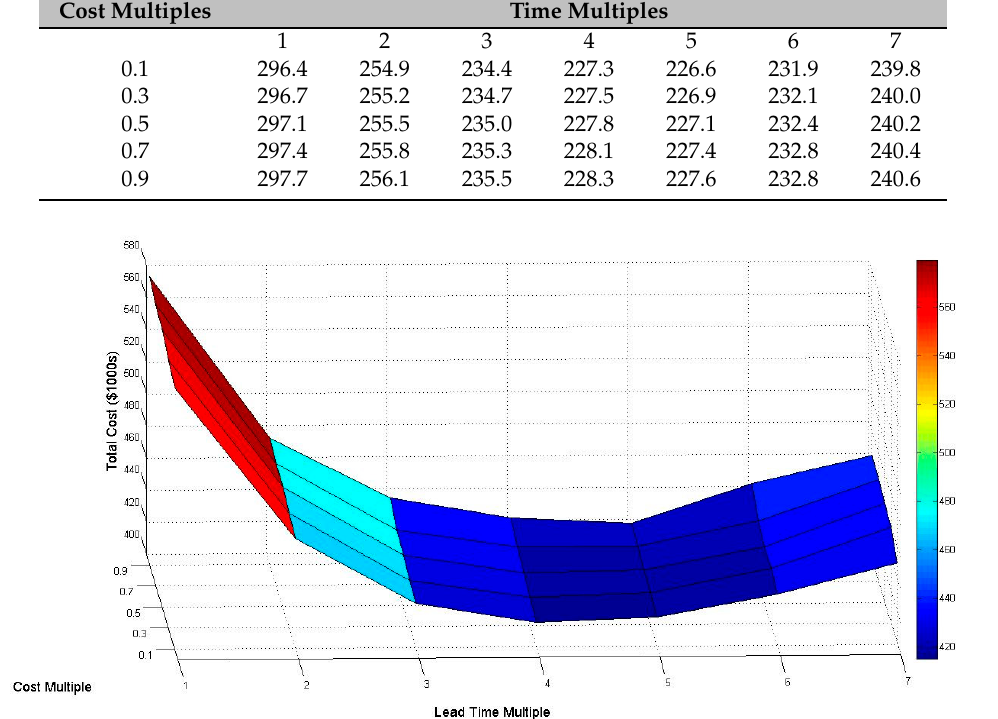
Figure 3. Results for the large instance set.